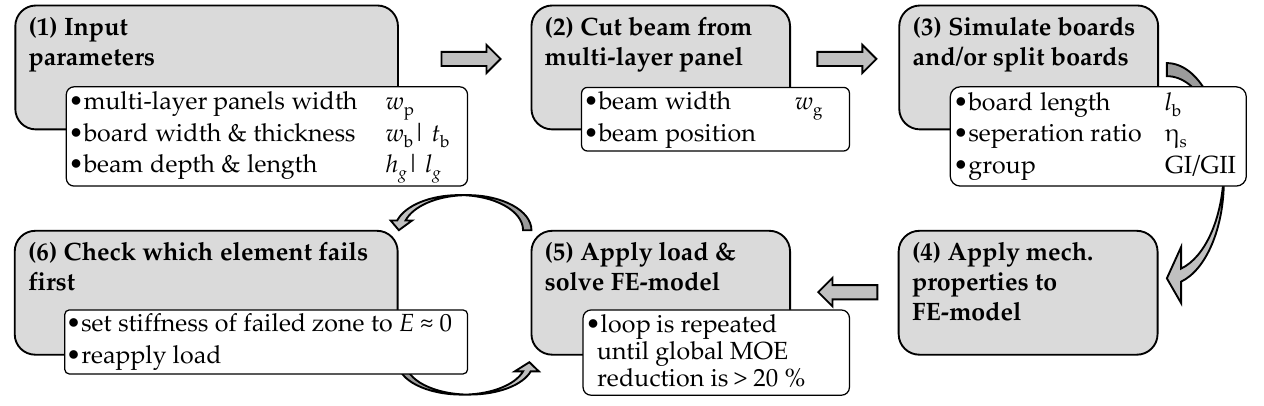
Figure 19. Beam generation and simulation process.